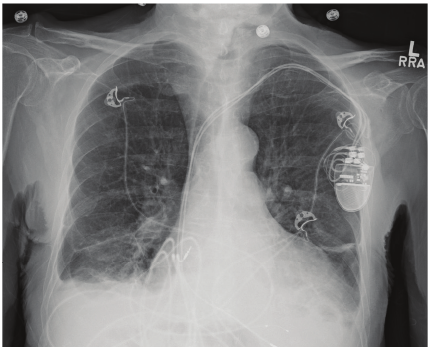
Figure 1: Chest X-ray demonstrating cardiomegaly, pleural e ff u- sions, and pulmonary vascular congestion.